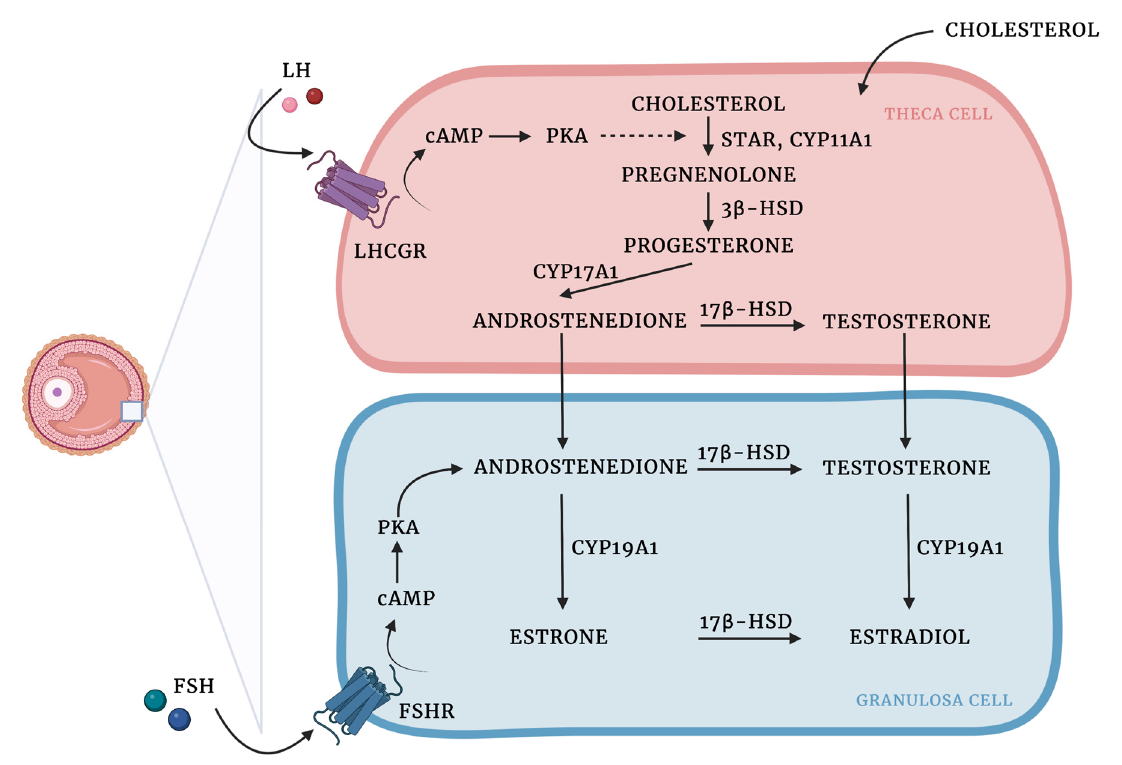
Figure 1. Ovarian steroidogenesis: two cell, two-gonadotropin theory. Ovarian steroids are synthesized from cholesterol, which diffuses from the circulation into theca cells and is mobilized into mitochondria by steroidogenic acute regulatory protein (STAR) activity [102]. LH binds to LHCGR on the cell surface, which results in the increased expression of steroidogenic enzymes involved in androgen production. Cholesterol is then converted into pregnenolone by the cholesterol sidechain cleavage enzyme (CYP11A1). In the smooth endoplasmic reticulum, pregnenolone is transformed into progesterone due to the activity of 3 β -hydroxysteroid dehydrogenase (3 β -HSD). Then, due to the activity of CYP17A1 progesterone is converted to androstenedione, which in turn might be transformed into testosterone by 17 β -hydroxysteroid dehydrogenase (17 β -HSD) or translocated into the GCs, where aromatase (CYP450arom; CYP19A1) converts androstenedione to estrone and testosterone to estradiol. 17 β -HSD might also produce estradiol using estrone as a substrate [103–106]. Created with BioRender.com.